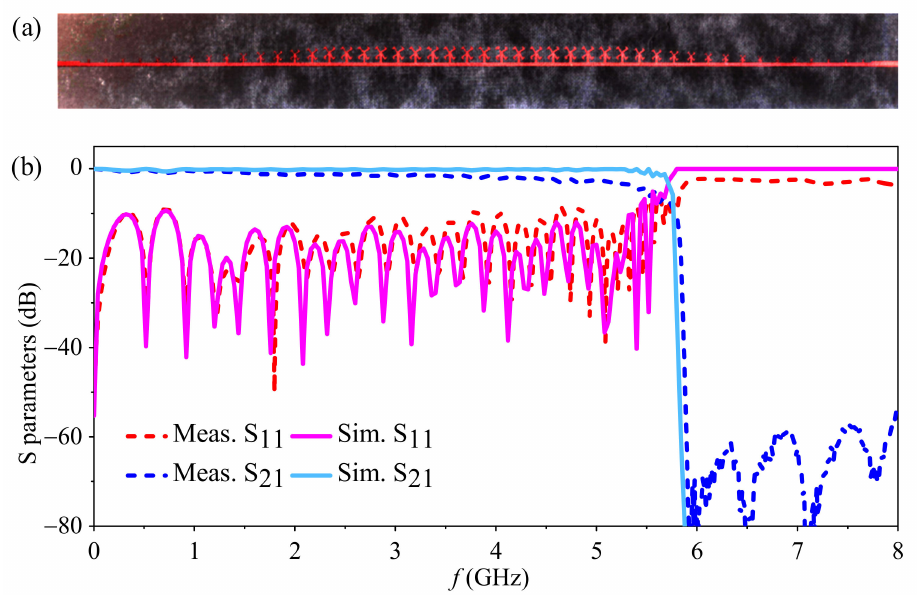
Figure 6. Microwave waveguide prototype and S parameters. ( a ) Fabricated microwave windmill-shaped SSPP waveguide prototype; ( b ) simulated and measured S parameters of the SSPP waveguide